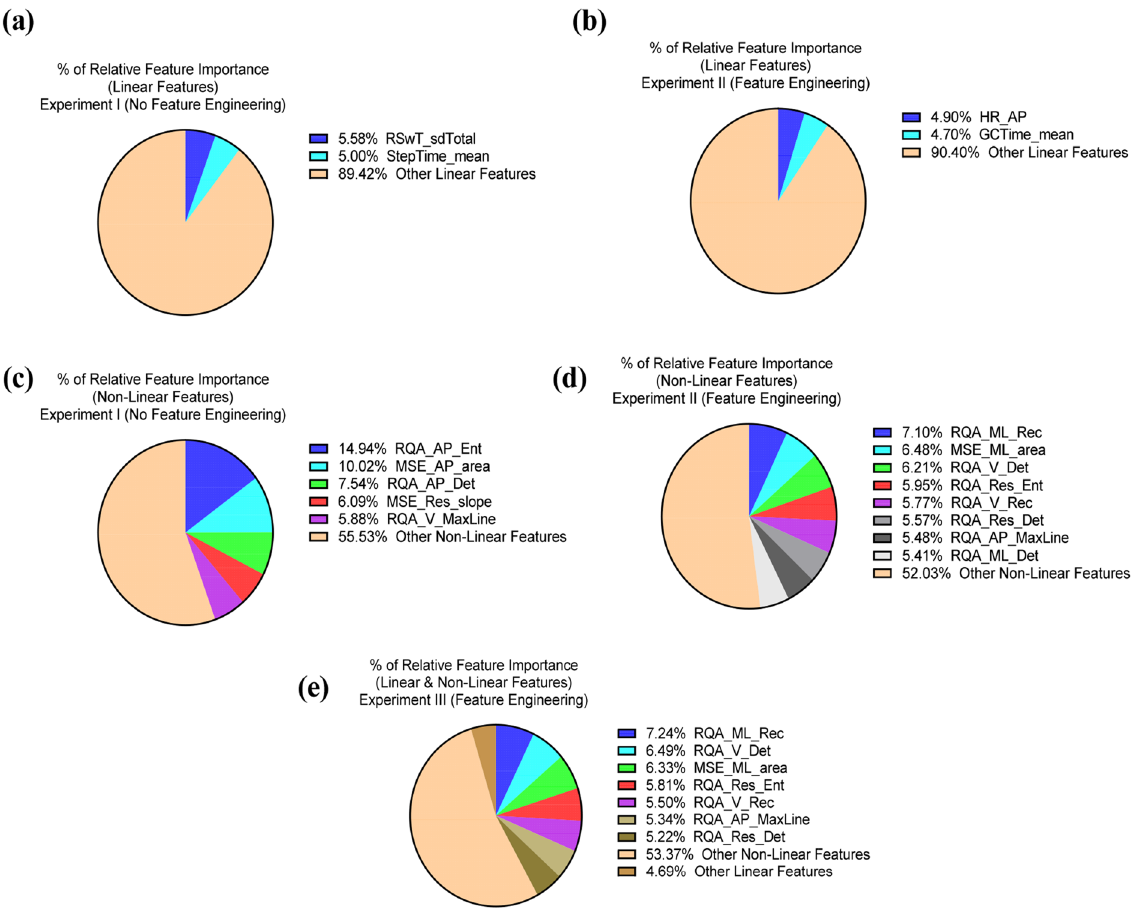
Figure 4. ( a ) linear features with high relative importance in experiment I, ( b ) linear features with high relative feature importance in experiment II with feature engineering, ( c ) Nonlinear features with high relative feature importance in experiment I, ( d ) Nonlinear features with high relative feature importance in experiment II and ( e ) a combination of linear and nonlinear features with high relative feature importance in experiment III. OOB error Number of trees Number of random features at each